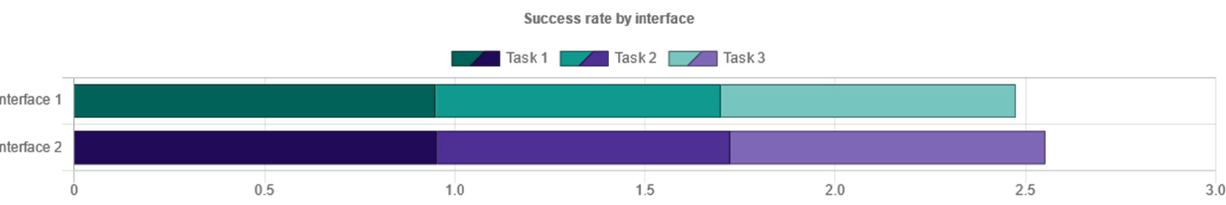
Figure 7. Success rate by interface.